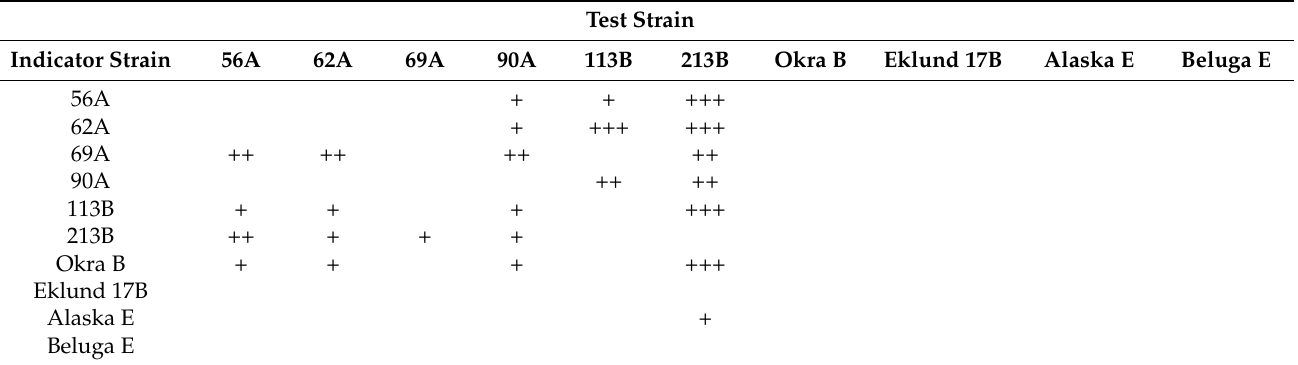
Table 2. Inhibition between strains based on the well diffusion assay. Average radius of inhibition zone (n = 3): +: small (<2 mm), ++: medium (2–5 mm), and +++: large (>5 mm). Test